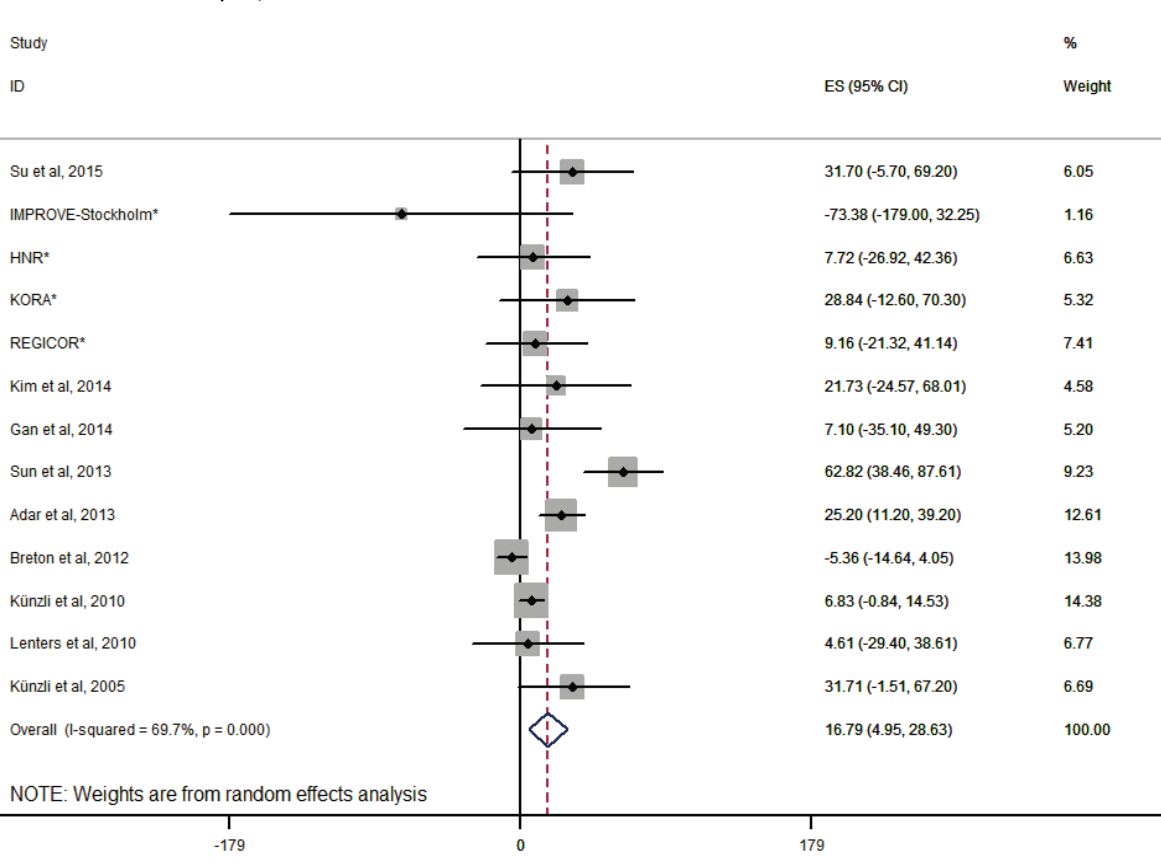
Figure 2. Forest plot for overall analysis of the association between PM 2.5 and CIMT (random-effects model); * four on-going European cohort analyzed by Perez et al.